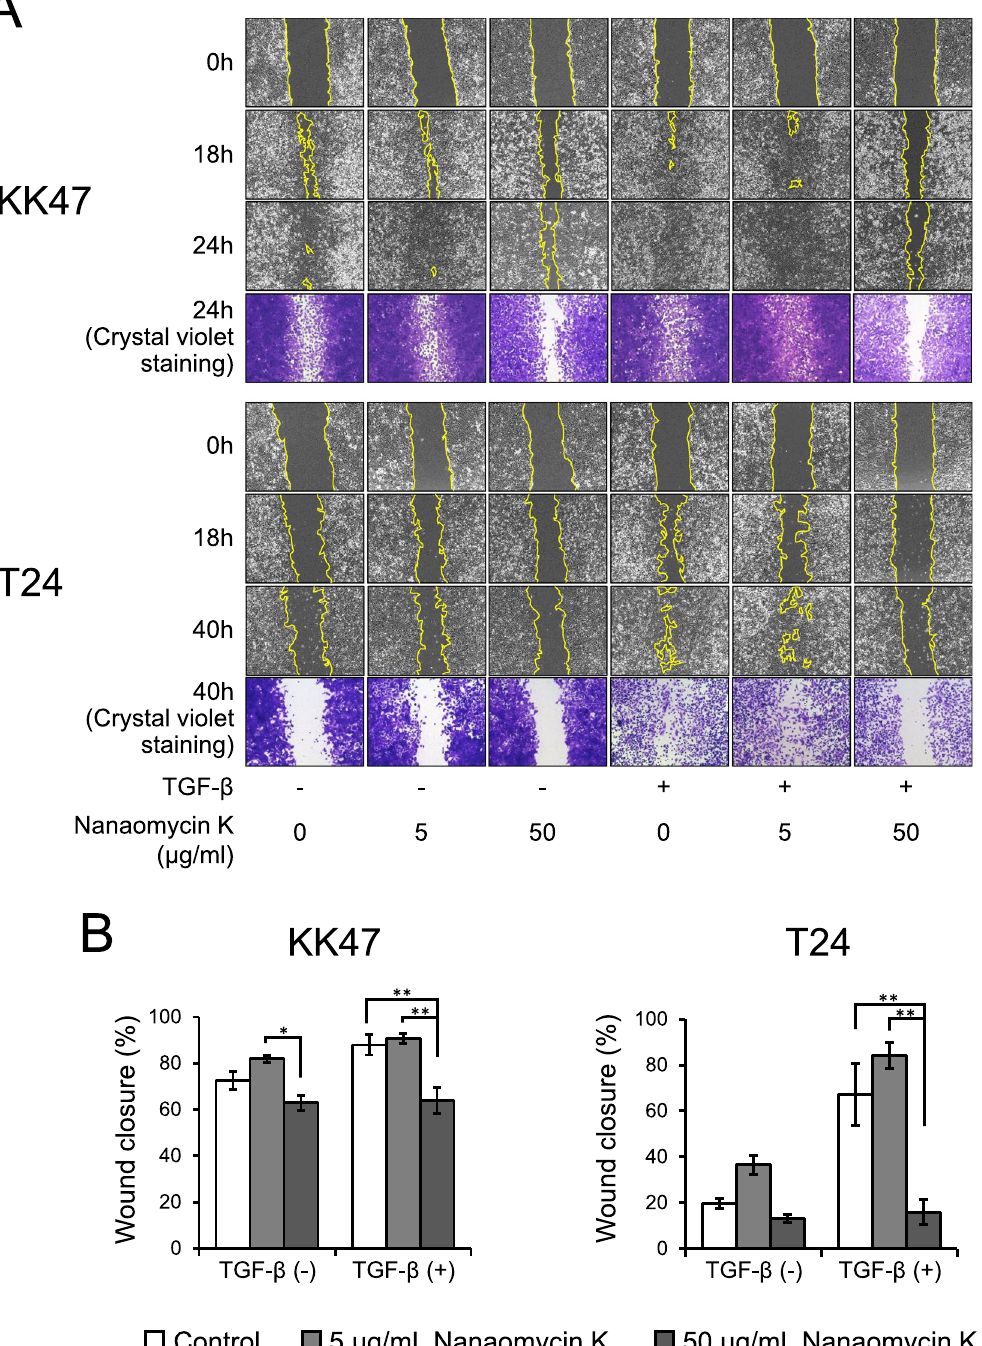
Figure 2. Wound healing assay. Invasion and migration ability was investigated in the presence of nanaomycin K (5 µg/mL or 50 µg/mL) with or without TGF-β in KK47 and T24 cell lines (100 ×) up to 40 h cultures ( A ). Control cells were treated with DMSO (vehicle control). Representative figures are shown. Wound closures compared to the wound at 0 h were shown ( B ) (n = 4, average ± SE bars, * p < 0.05, ** p <